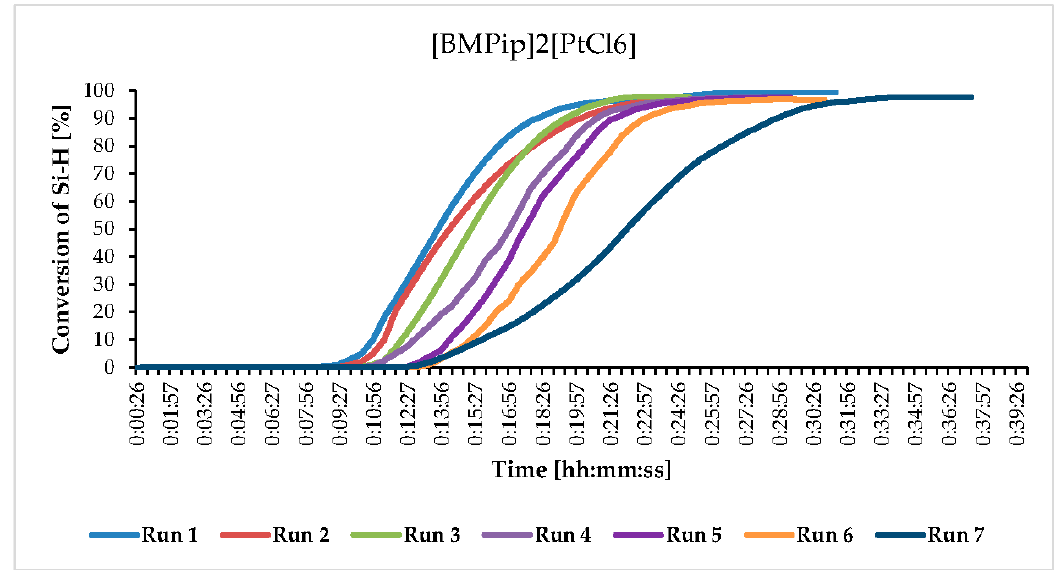
Figure 3. The change in the conversion of ≡ SiH as a function of time for the reaction catalyzed by [BMPip] 2 [PtCl 6 ].